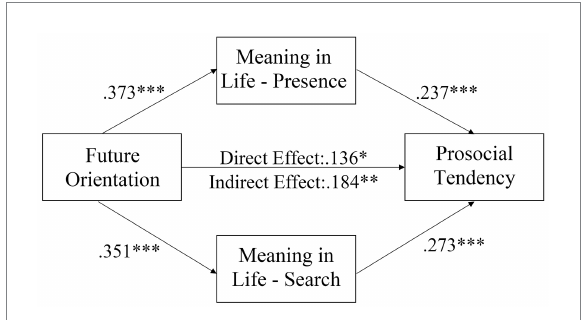
FIGURE 4 A hypothetical model for the relationships among major variables (female sample). * p < 0.05; ** p < 0.01, *** p <